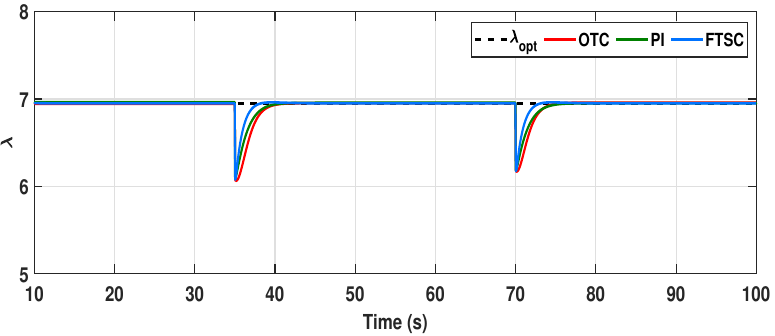
Figure 9. Comparative evaluation of tip speed ratio ( λ ) under step wind profile.